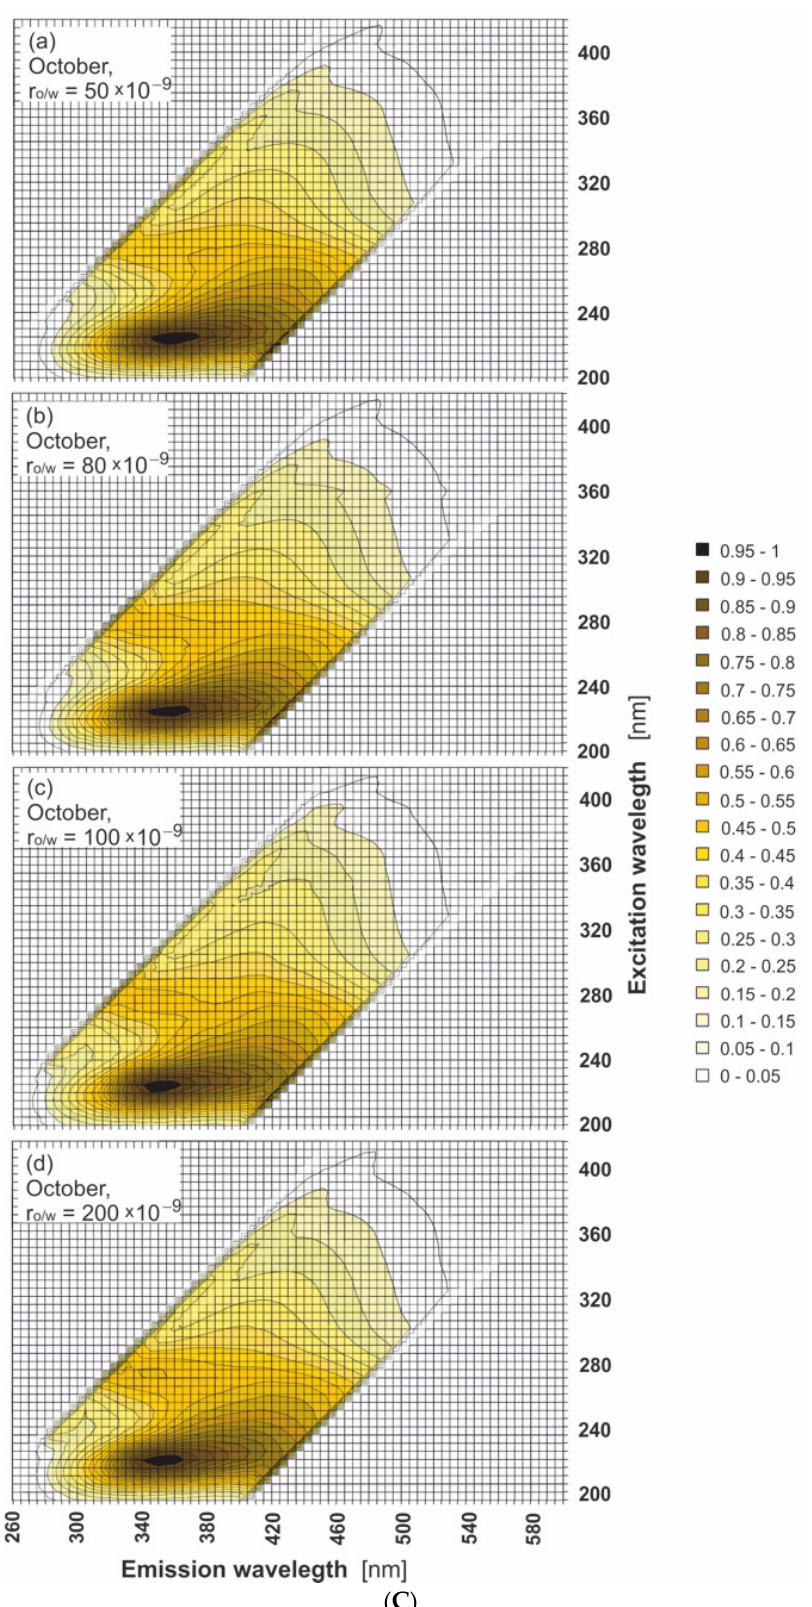
Figure 4. Excitation–emission spectra of seawater polluted with oil for various oil-to-water ratios: 50 × 10 − 9 ( a ), 80 × 10 − 9 ( b ), 100 × 10 − 9 ( c ), and 200 × 10 − 9 ( d ), for selected months: May ( A ), August ( B ), and October ( C ).